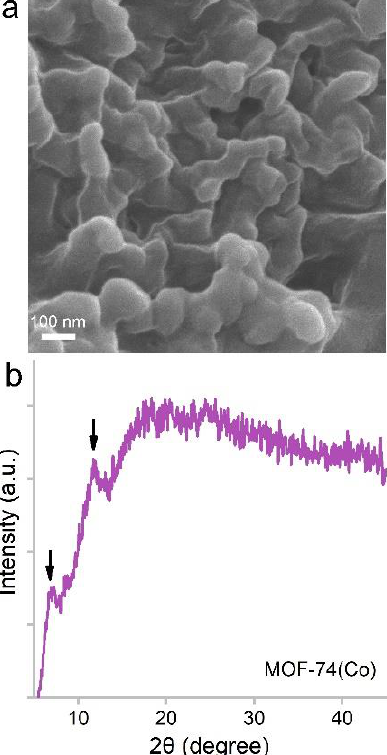
Figure 1. SEM image ( a ) and XRD spectrum ( b ) of MOF-74(Co) NPs. The arrows indicate the characteristic XRD peaks of MOF-74(Co) NPs.